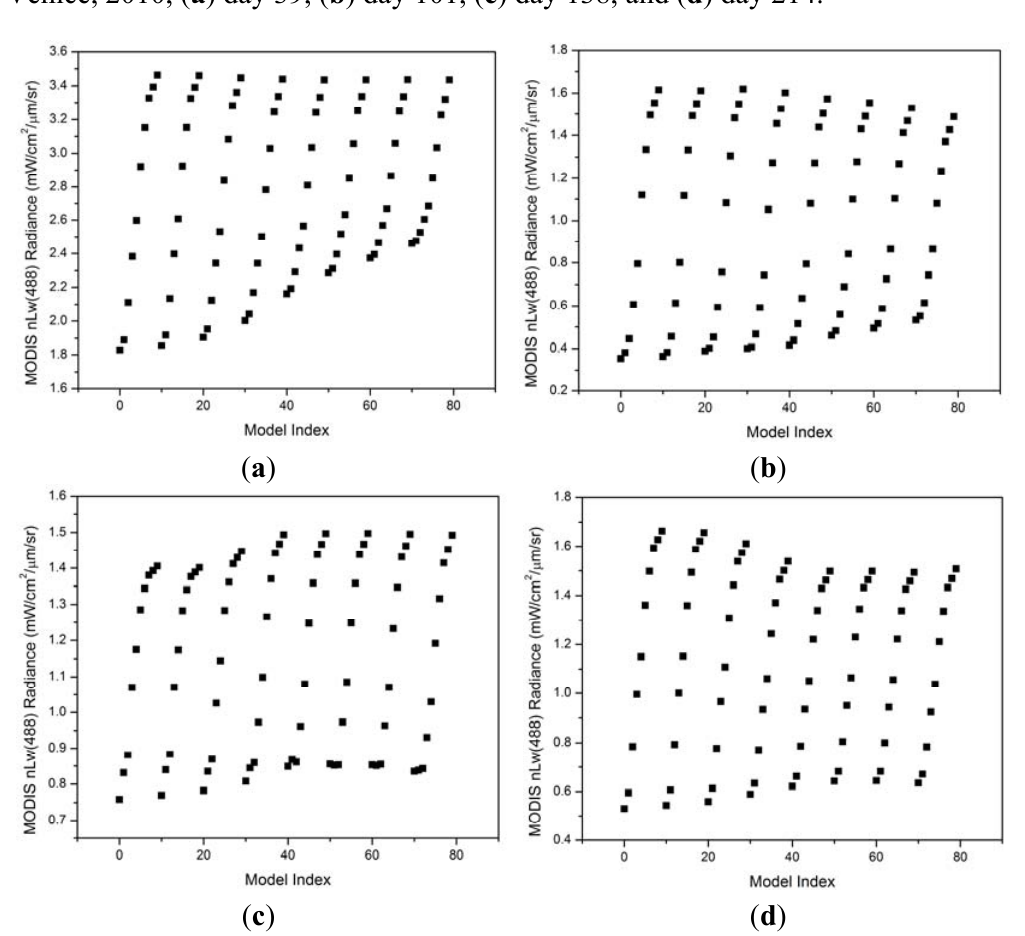
Figure 2. MODIS retrieved